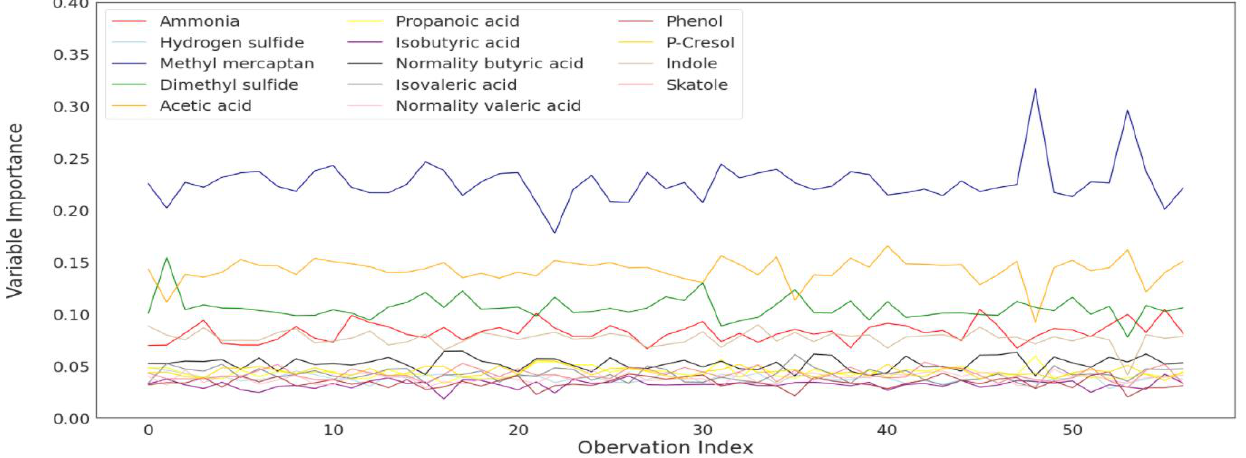
Figure 13. Variable importance plot about the best model in Table 3.